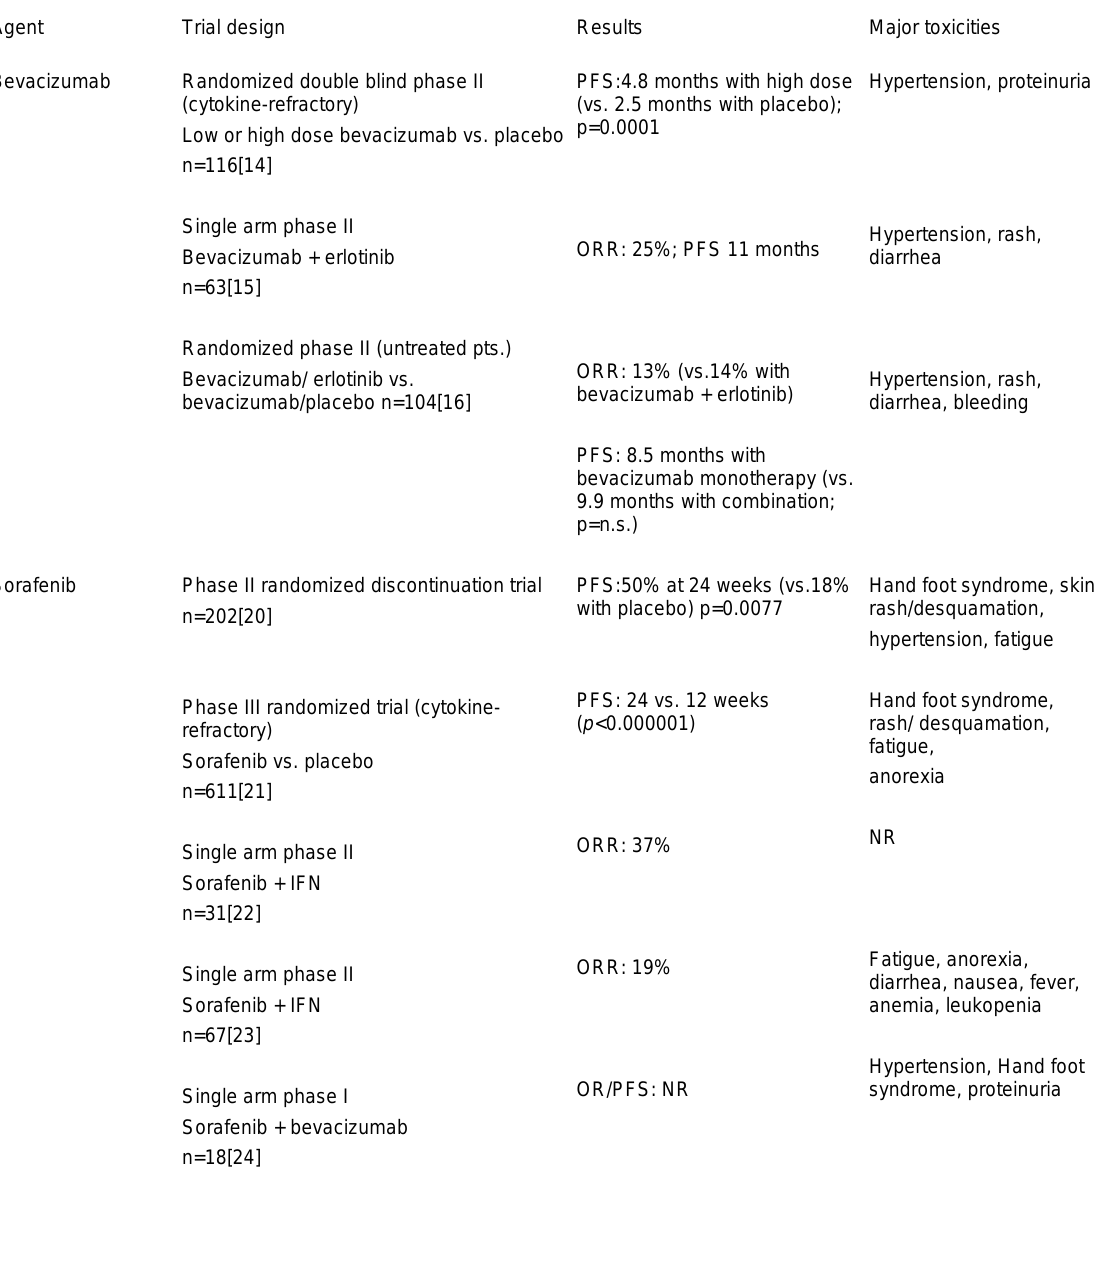
Summary of select phase II /III trials using targeted therapy in metastatic